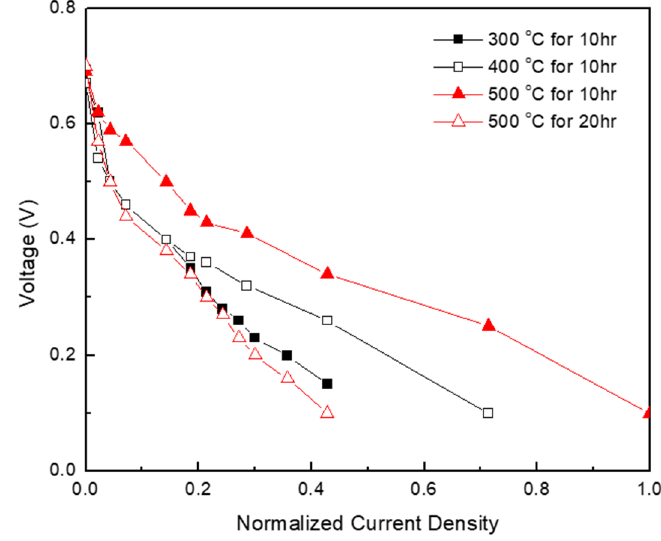
Figure 3. Effect of thermal treatment on the cell performance for various treatment conditions. The performances were measured with cells having cathode carbon porous electrode (CPE) samples treated at various thermal treatment conditions.